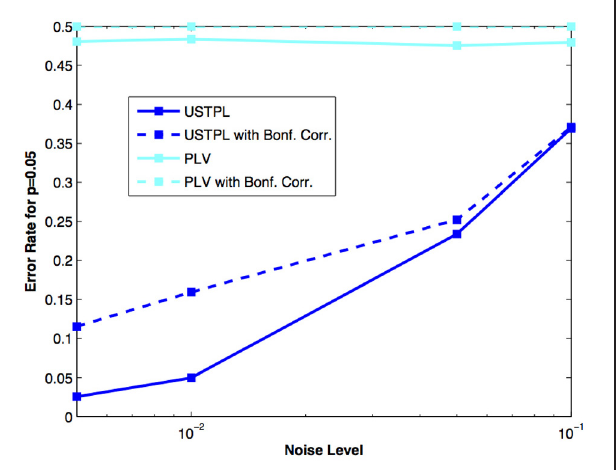
FIGURE 8 | Comparison of error rates at p = 0 . 05 with and without Bonferroni correction between PLV and USTPL methods. Dotted lines indicate error rates at Bonferroni-corrected significance values. USTPL is significantly lower than PLV at all tested noise levels.